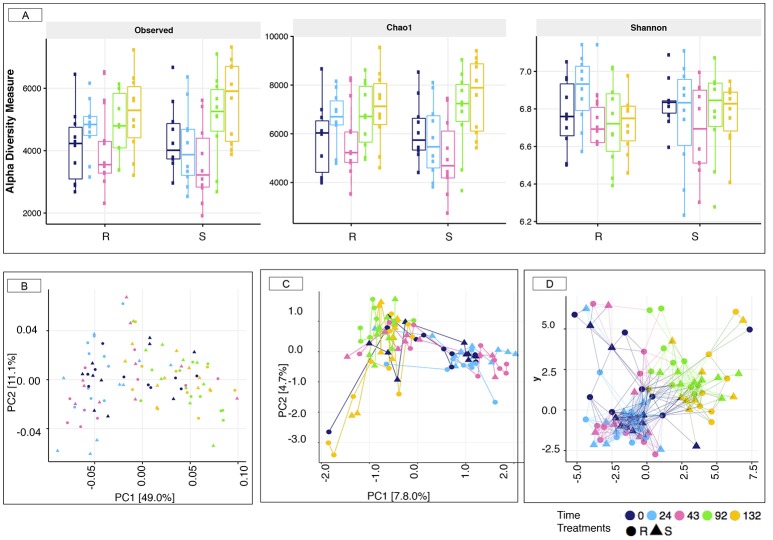
Estimation of the α-diversity indexes and β-diversity in susceptible and resistant animals across the experiment. (A) Estimation of the α-diversity indexes in susceptible (S) and resistant (R) across the experiment. The box color indicates the time point analyzed: (dark blue = 0 days, cyan = 24 days, pink = 43 days, green = 92 days, and yellow = 132 days); (B) Principal Coordinate analysis of weighted Unifrac distances to compare fecal communities at the level of OTUs that differ between S and R animals across the experiment. Both PC axes 1 and 2 were plotted. Together they explained 60.1% of whole variation; (C) Correspondence analyses of weighted Unifrac distances to compare fecal communities at the level of OTUs that differ between S and R animals across natural parasite infection. Both CA axes 1 and 2 were plotted; (D) Genus-level network representation between ponies across the experiment linked within a specified Jaccard distance of 0.85. Two samples were considered “connected” if the distance between them was <0.85. In all cases, the relative position of points was optimized for the visual display of network properties. The point's shape indicates the susceptibility to strongylosis (triangle: S; round: R), the node color indicates the time point analyzed: (dark blue = 0 days, cyan = 24 days, pink = 43 days, green = 92 days, and yellow = 132 days).